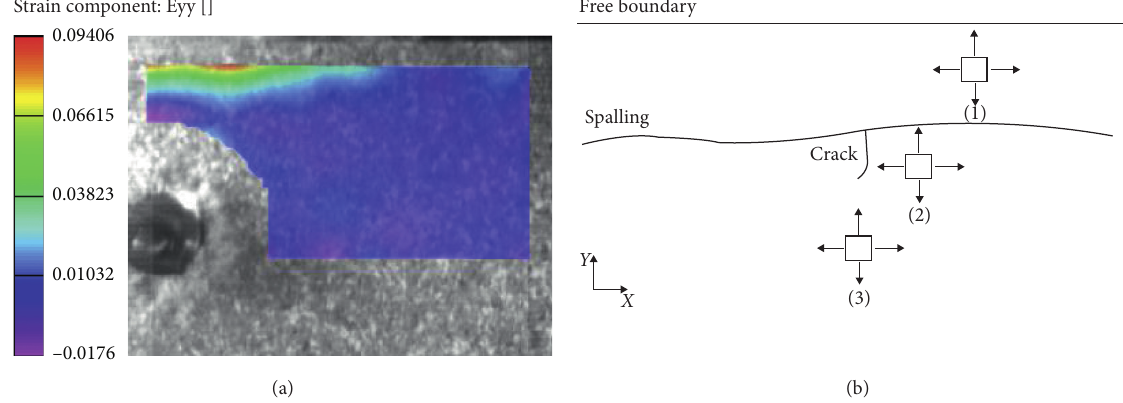
Figure 6: Strain field characteristics. (a) Vertical strain field and (b) diagrammatic drawing of strain field.